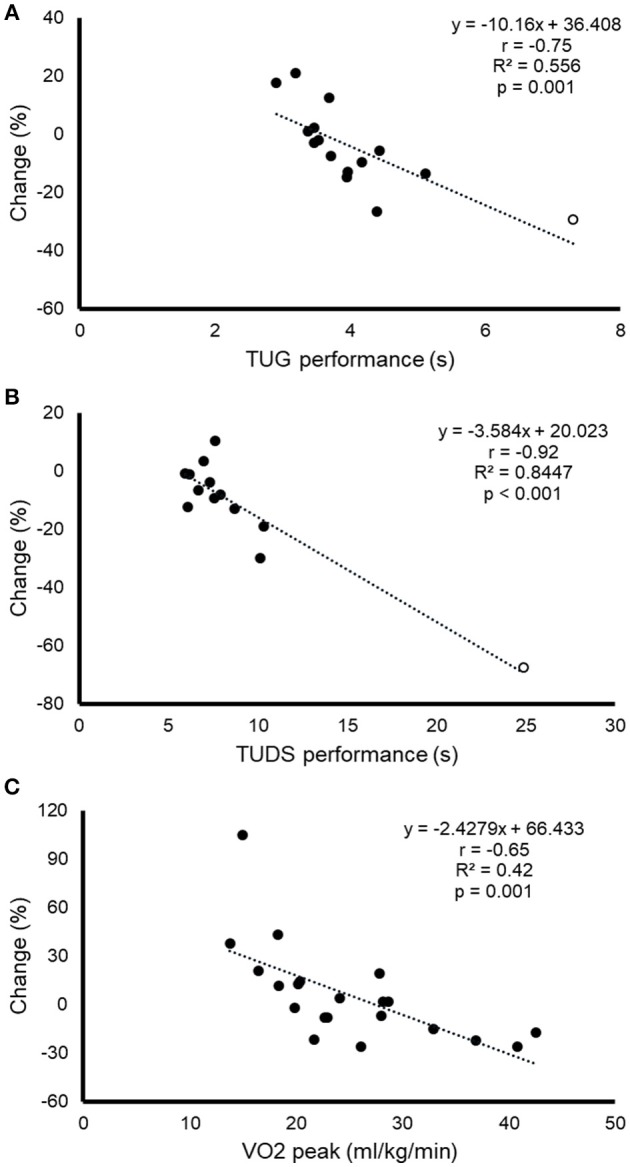
Relationship between baseline performance in the timed up and go (TUG) test (A), the timed up and down stair (TUDS) test (B) and cardiorespiratory fitness [CRF, expressed as peak oxygen uptake [VO2peak]), (C)], on the one hand, and the relative change in performance for each test after the exercise training intervention, on the other. When outliers [white dots in (A,B)] were removed from the analysis, the relationship was still significant for both TUG (r = −0.74, p = 0.002) and TUDS (r = −0.68, p = 0.01).